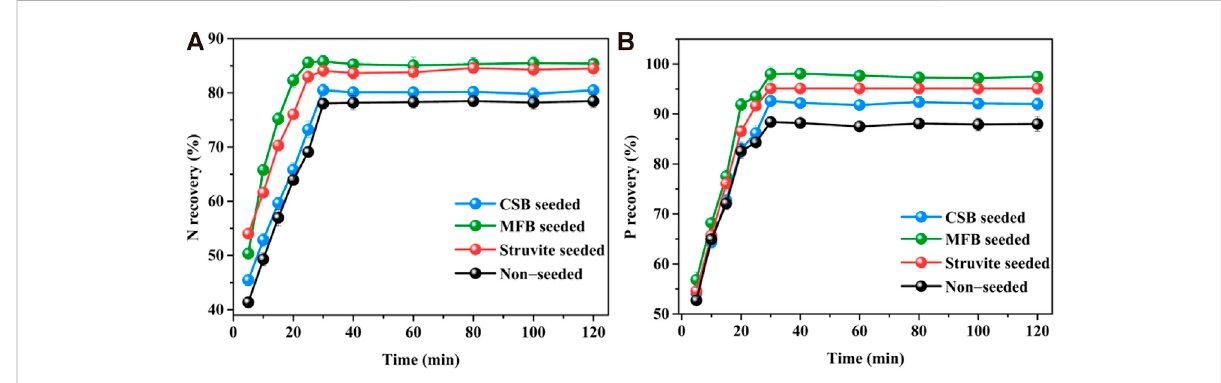
FIGURE 6 Effect of variation in reaction time on nutrients recovery through struvite precipitation with various seeding materials from rural RTS refuse leachate (A) N recovery and (B) P